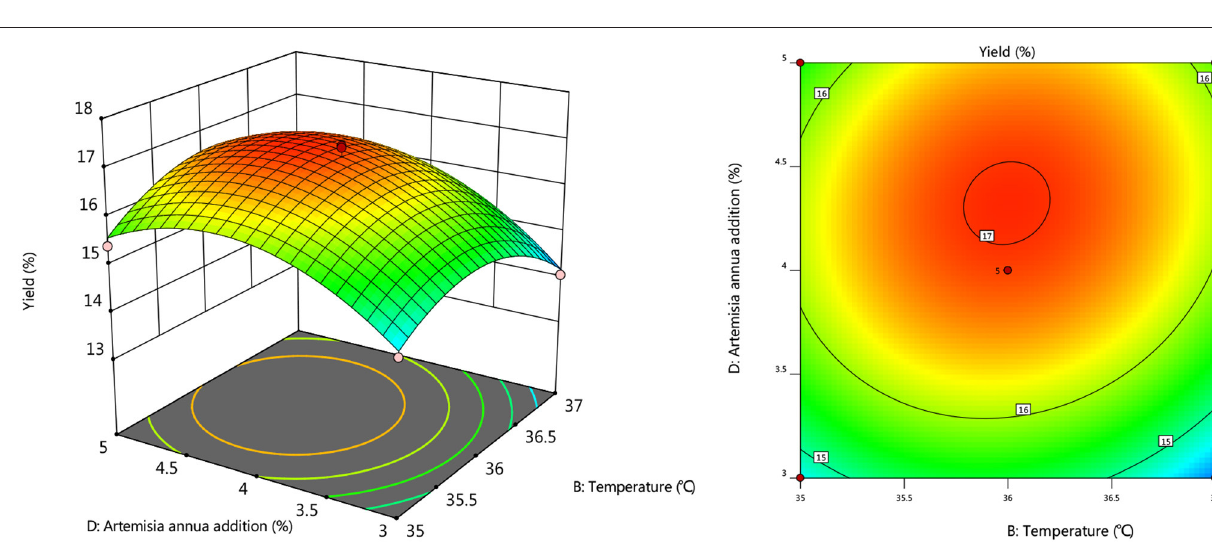
FIGURE 10 | Response plot of the interaction between temperature and Artemisia annua addition on